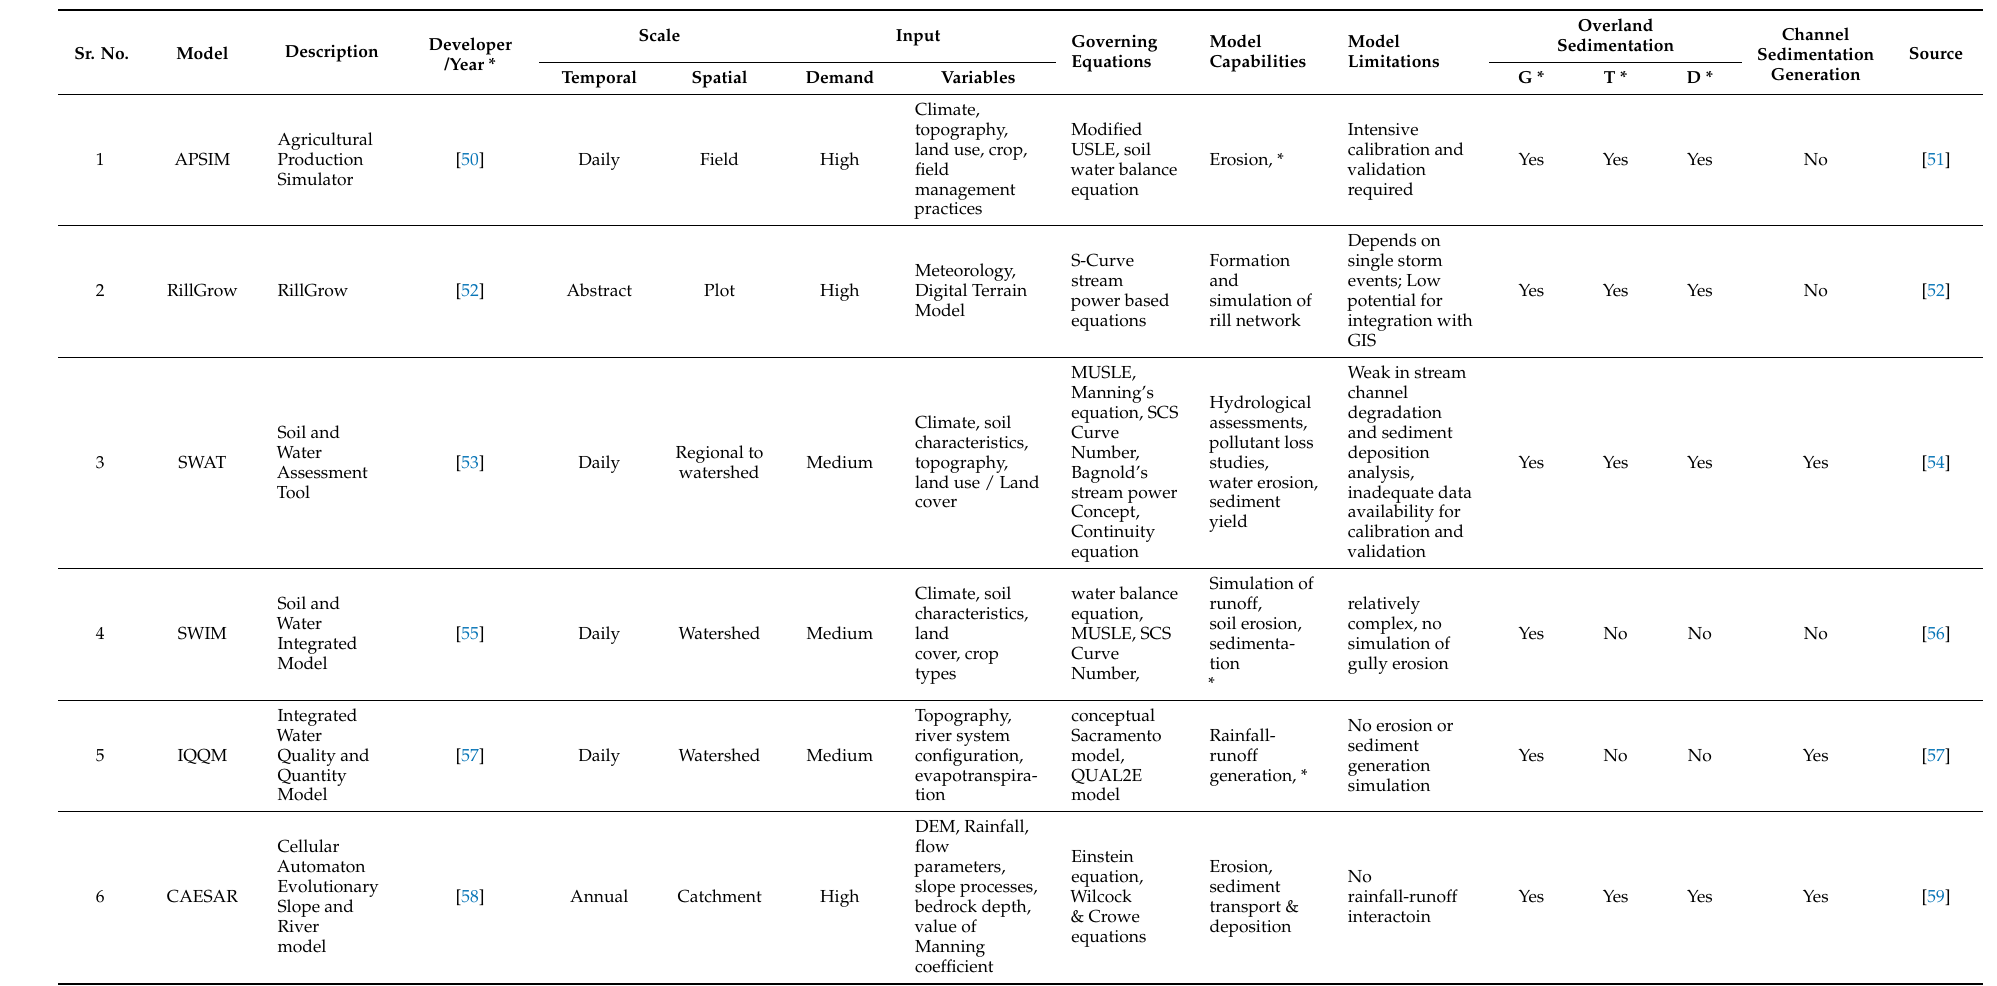
Table 4. Conceptual soil erosion